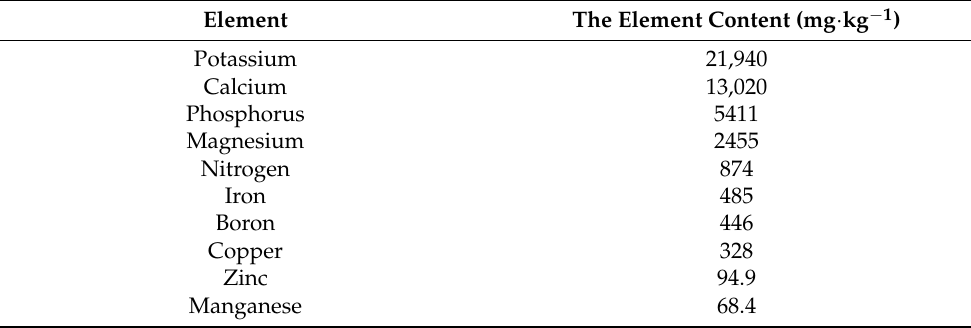
Table 6. Elemental composition observed in the freshwater L. minor